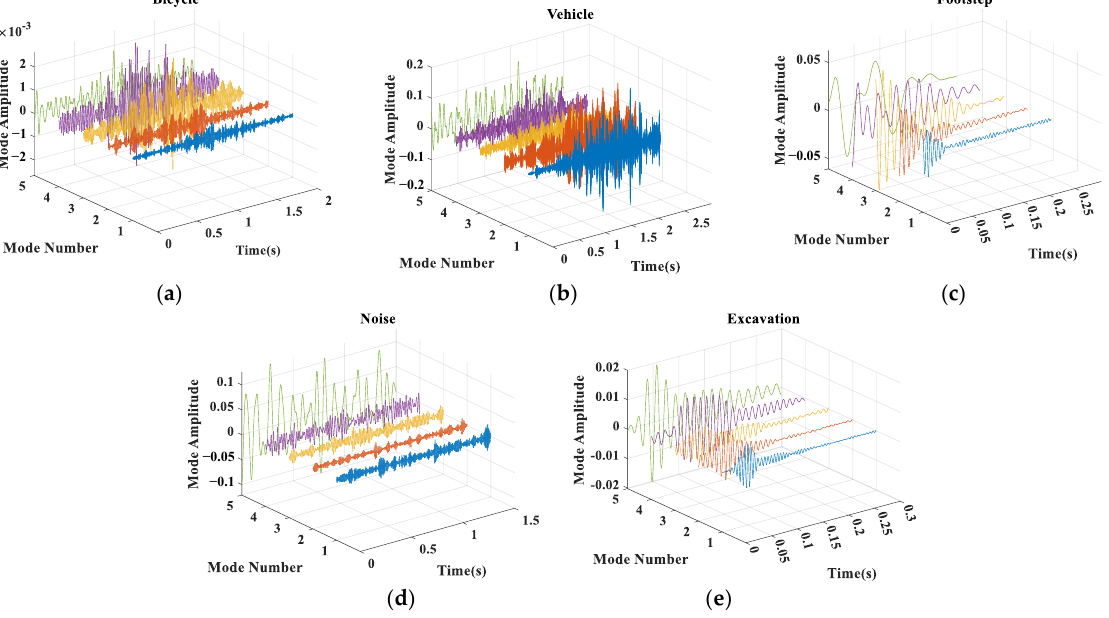
Figure 3. VMD of different ground intrusion seismic signals to obtain band-limited intrinsic mode function (BIMF). ( a ) Five BIMF components of one bicycle signal. ( b ) Five BIMF components of one vehicle signal. ( c ) Five BIMF components of one footstep signal. ( d ) Five BIMF components of one noise signal. ( e ) Five BIMF components of one excavation signal.